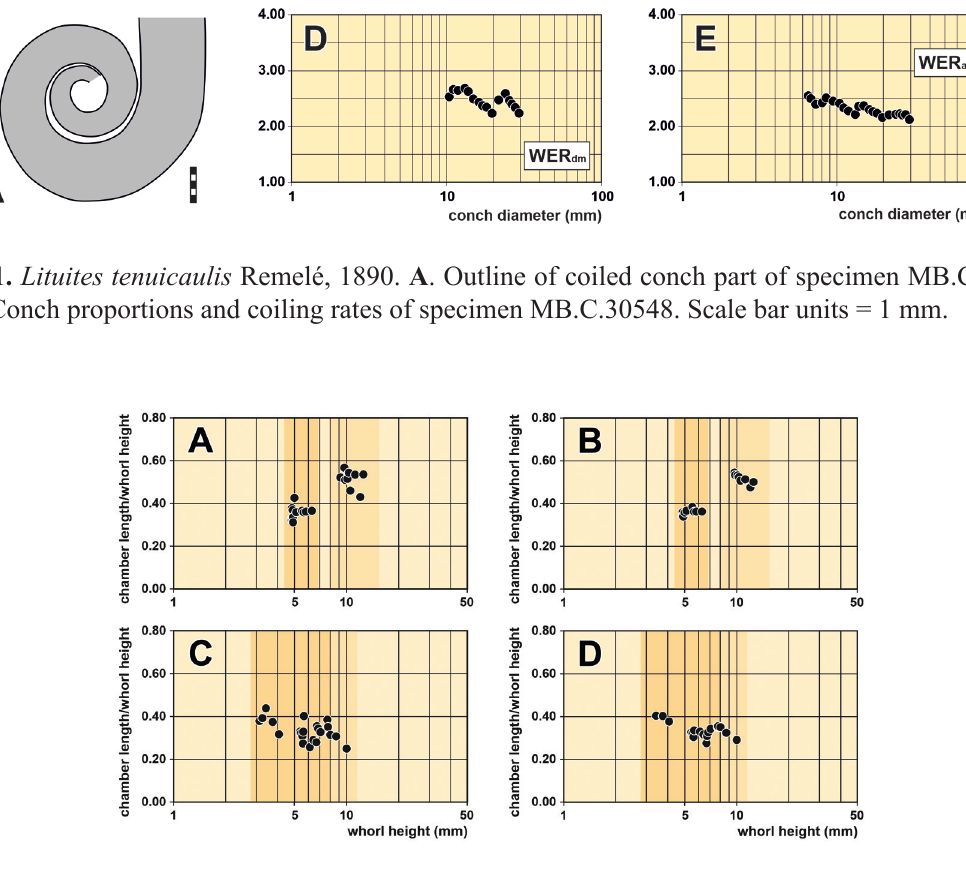
Fig. 52. Septum distances in Lituites tenuicaulis Remelé, 1890 from the Upper Grey Orthoceratite Limestone. A, C = empirical data points; B, D = three data points averaged. A–B . Lectotype MB.C.5389 (Kgl. Forstakademie Eberswalde Coll.) from Oderberg (Brandenburg). C–D . Specimen MB.C.30548 (Neben & Krueger Coll.) from Niederfinow